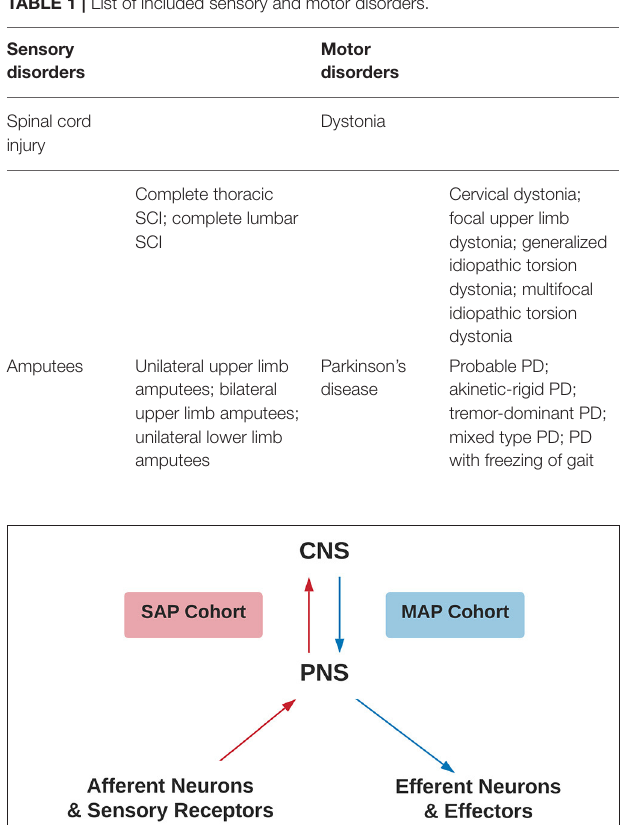
TABLE 1 | List of included sensory and motor disorders.